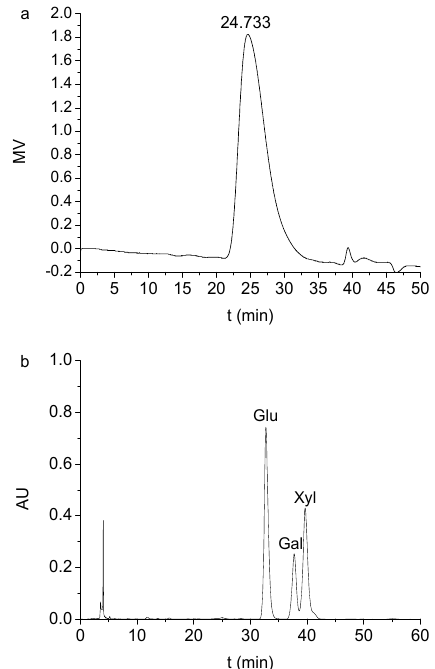
Figure 1. ( a ) The elution curve of TSP solution at 2 mg/mL by HPSEC; ( b ) The elution curve of PMP derivatives of TSP hydrolysate by HPLC.